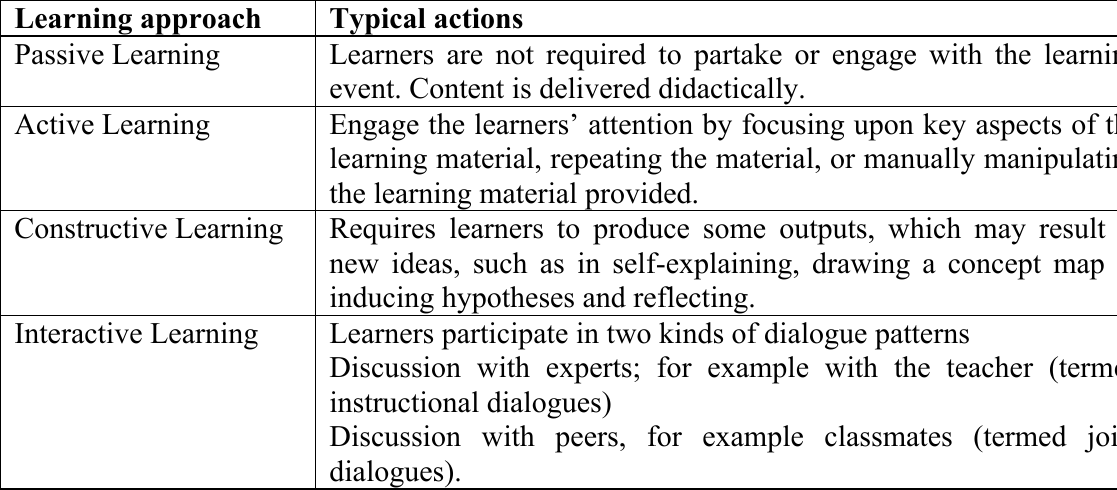
Table One: Learning approach synopsis comparing active, constructive and interactive teaching approaches. Adapted from Chi